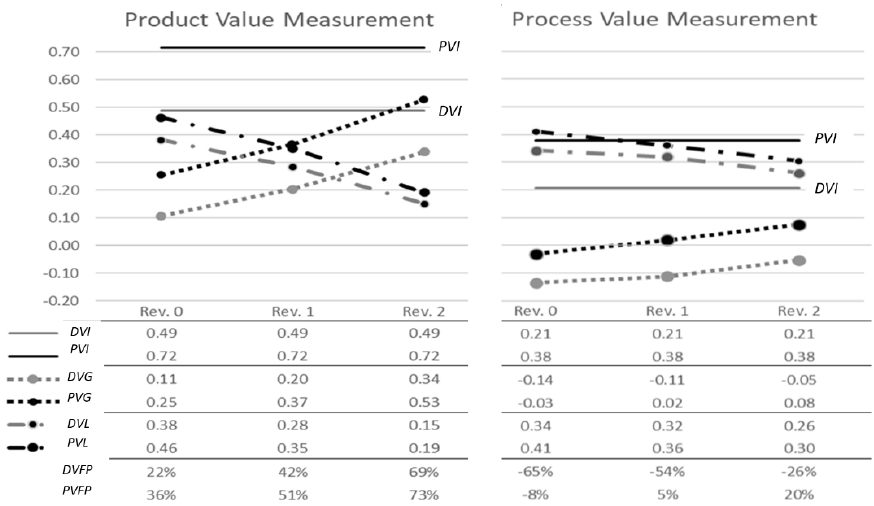
Figure 5. Value Figure 5. Value evolution.